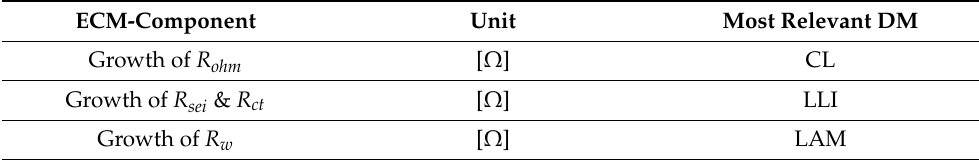
Table 2. The relationship between ECM resistance and the most pertinent DMs [27].